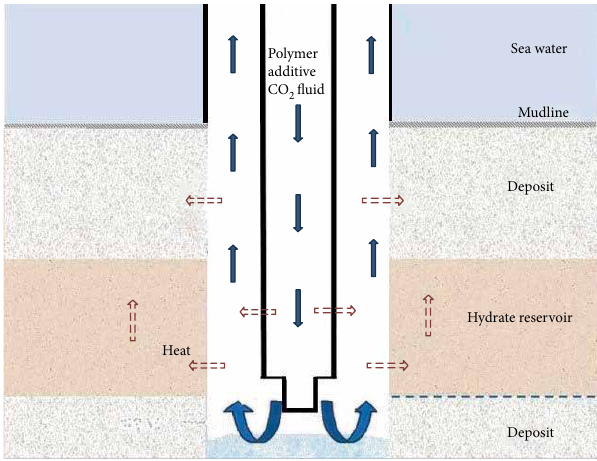
fluid injection 2